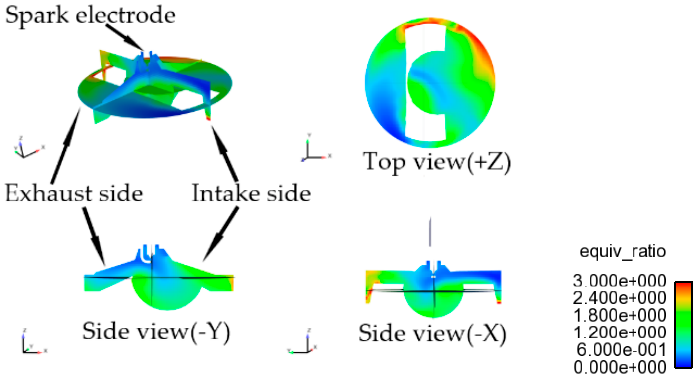
Figure 8. Equivalence ratio of fuel/air at − 20 °CA.